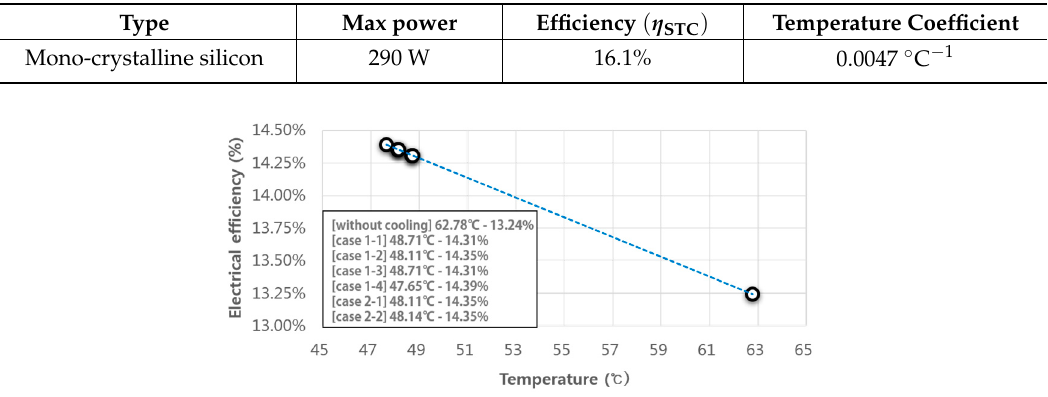
Table 6. PV module specifications.